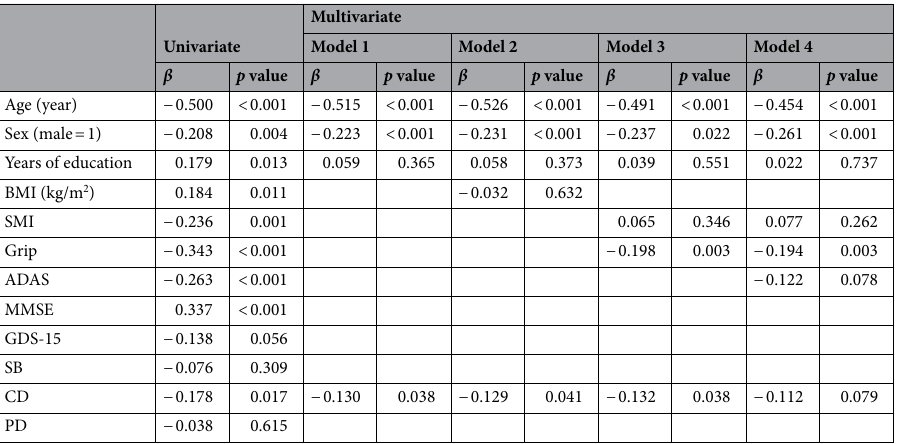
Table 4. Regression analysis for maximum gait speed. Cut-off point for GDS-15 was 5/6; Cut-off point for handgrip strength of < 28 kg for men and < 18 kg for women; cut-off for low SMI was < 7.0 kg/m 2 in men and < 5.7 kg/m 2 in women. Model 1 (adjusted for age, sex, and educational years), model 2 (model 1 + BMI), model 3 (model 1 + SMI and grip), model 4 (model 3 + ADAS). ADAS Alzheimer’s disease assessment scale, MMSE mini mental state examination, GDS geriatric depression scale, BMI body mass index, SMI skeletal muscle mass index, CI confidential interval, SB stimulus bound, CD conceptual deficits, PD planning